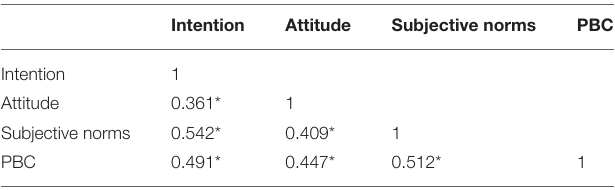
TABLE 3 | Correlations between the scales of the Theory of Planned Behavior (TPB).